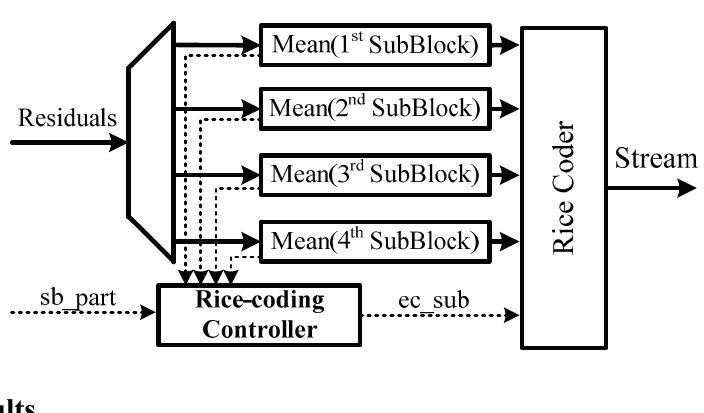
Figure 8. Residual entropy